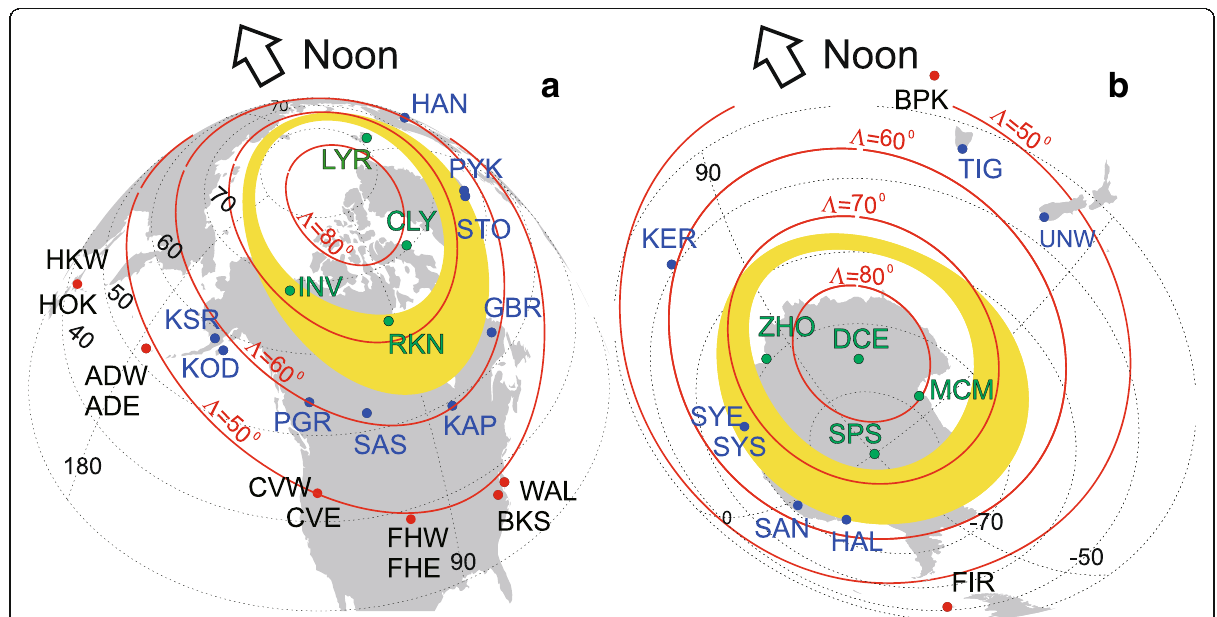
Fig. 5 Schematic plots showing the a Northern and b Southern Hemisphere SuperDARN radar locations with respect to the auroral oval. The auroral oval (yellow) for moderately disturbed conditions, as quantified by Holzworth and Meng (1975), is plotted as a function of AACGM coordinates with the SuperDARN radar locations identified in green type and green closed circles (polar cap latitudes), blue type and blue closed circles (auroral latitudes), and black type and red closed circles (mid-latitude radars)